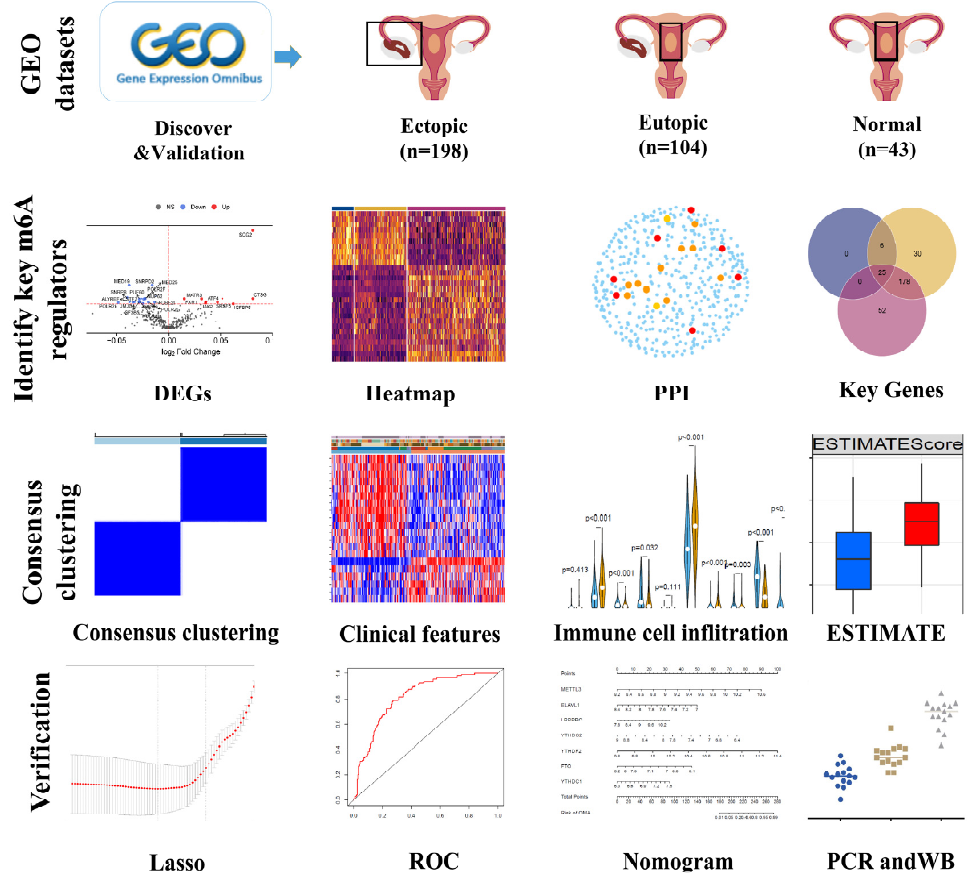
Figure 1. The entire workflow used in this study. Table 1. Clinical characteristics in GSE141549 (n = 345).